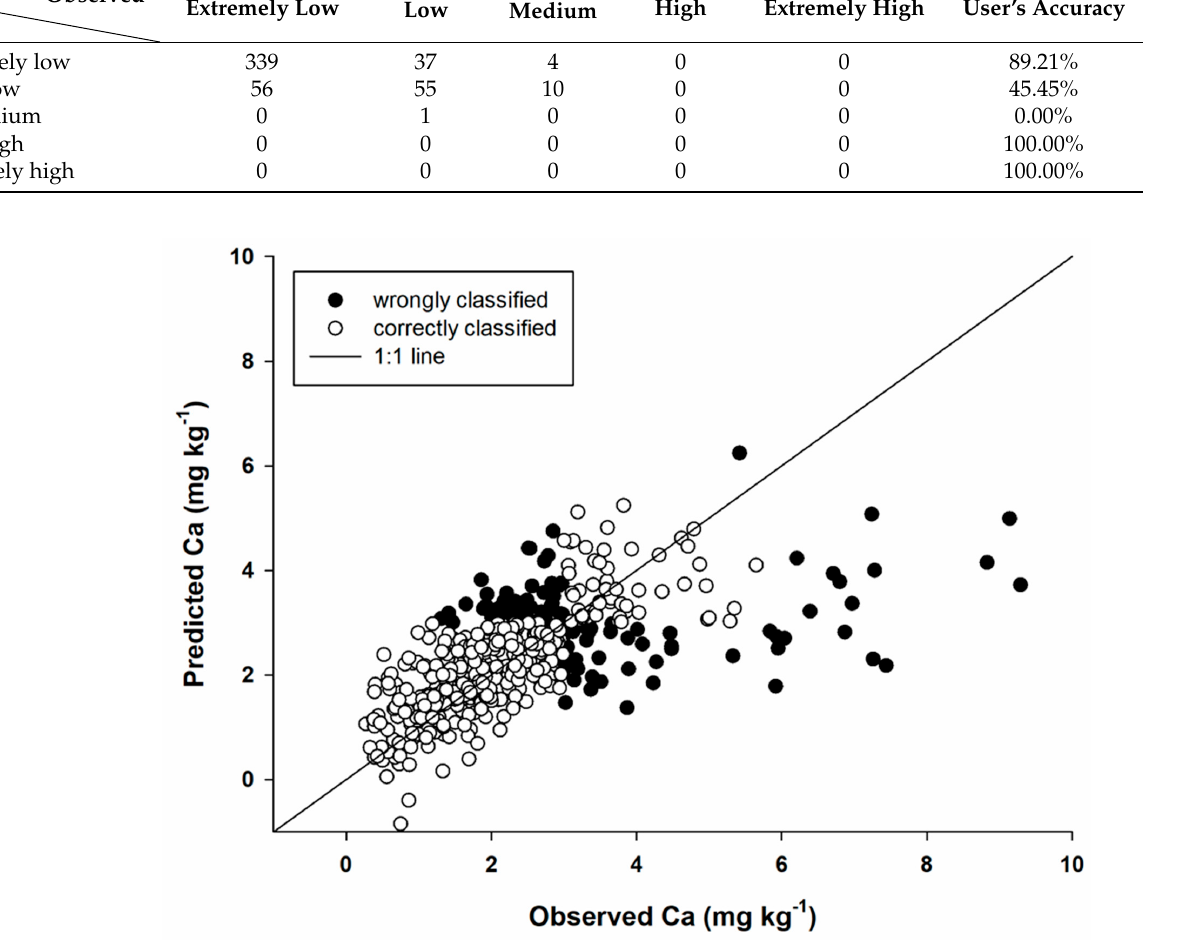
Figure 3. Scatterplot of the predicted Ca values versus the observed Ca values. Table 7. Allocation confusion matrix of Ca.